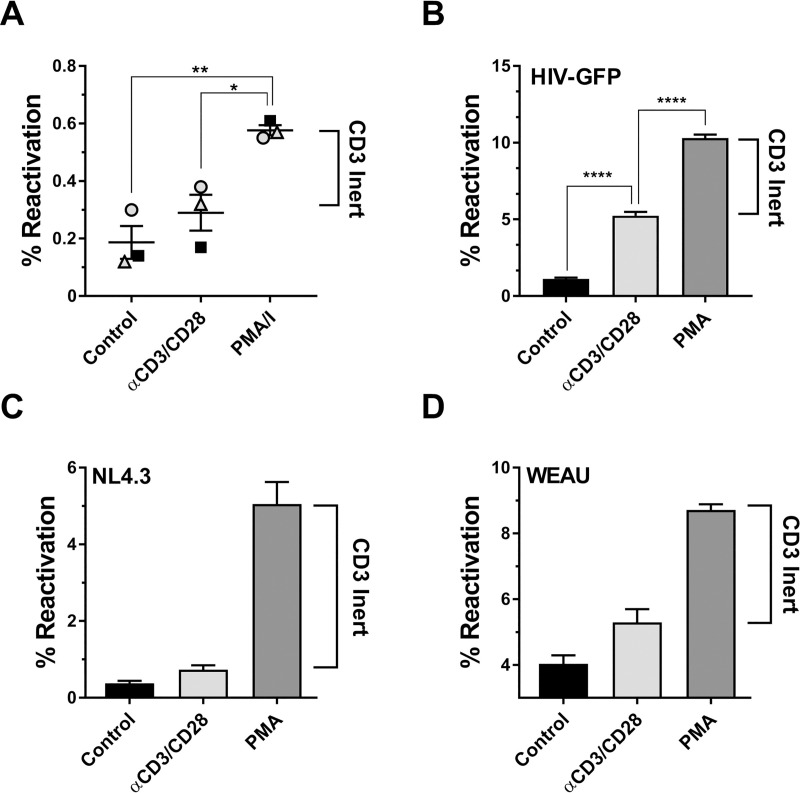
HIV-1 infection induced TCR/CD3 activation-inertness is conserved between primary T cells and T cell lines.(A) In vitro latently HIV-1 infected primary CD4+ T cells were generated as described under Methods using PBMCs from three different donors infected with a full-length GFP-reporter virus. The T cell infection cultures were then left unstimulated (control), stimulated with anti-CD3/CD28 mAb coated beads or stimulated with PMA/ionomycin. Using GFP expression as a surrogate marker, levels of active/reactivated HIV-1 expression were determined 72 hours post stimulation using flow cytometric analysis for GFP expression. The difference between the GFP+ frequencies following PMA/ionomycin stimulation and CD3/CD28 mAb stimulation for each donor represents the TCR/CD3 activation-inert reservoir. (B) Jurkat T cells were infected with a HIV-1 NL4-3 based GFP reporter virus and cultured for a total of 60 days in the presence of RT inhibitors until a stable viral reservoir had been established as previously described [29,30]. At this time, samples of the infection cultures were either left unstimulated, treated with anti-CD3/CD28 mAb coated beads or stimulated with PMA. Baseline HIV-1 expression levels in the untreated cells and HIV-1 reactivation in the stimulated cultures were determined using flow cytometric analysis for GFP expression. The difference between the GFP+ frequencies following PMA stimulation and CD3/CD28 mAb stimulation for each donor represents the TCR/CD3 activation-inert reservoir. Similar experiments were performed using a reporter T cell line that expresses GFP when actively HIV-1 infected (J-R5D4 cells). J-R5D4 T cells were infected with (C) HIV-1 NL4-3 or (D) HIV-1 WEAU, a primary HIV-1 patient isolate. Following six weeks of culture in the presence of RT inhibitors reactivation experiments were performed as in (B) and reactivation levels were determined by flow cytometric analysis for GFP expression. Data plotted as mean ± standard deviation of three independent experiments.